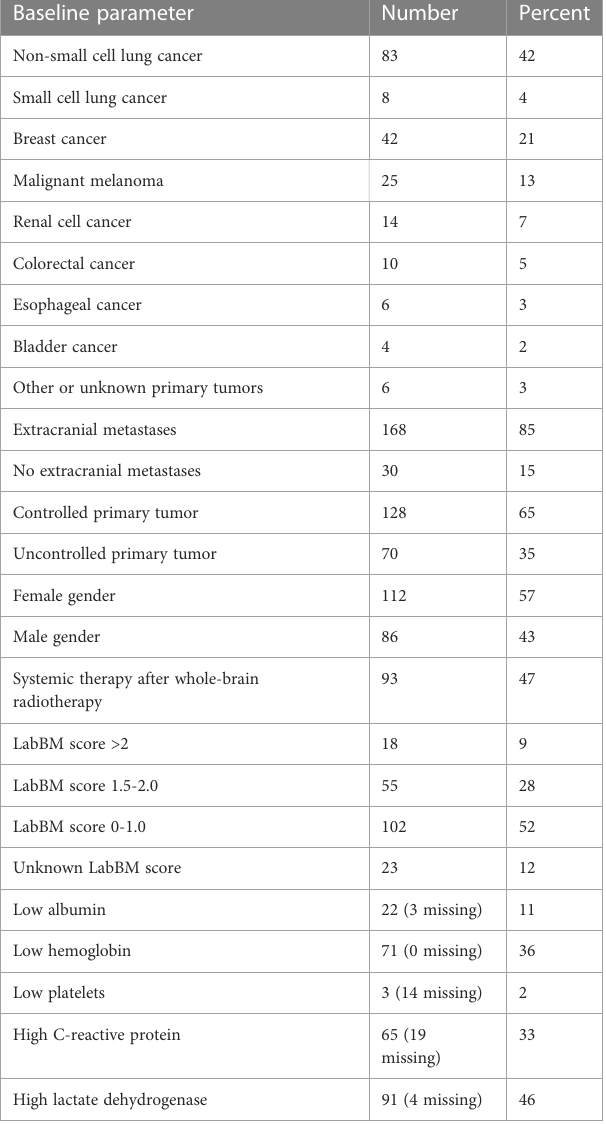
TABLE 1 Patient characteristics